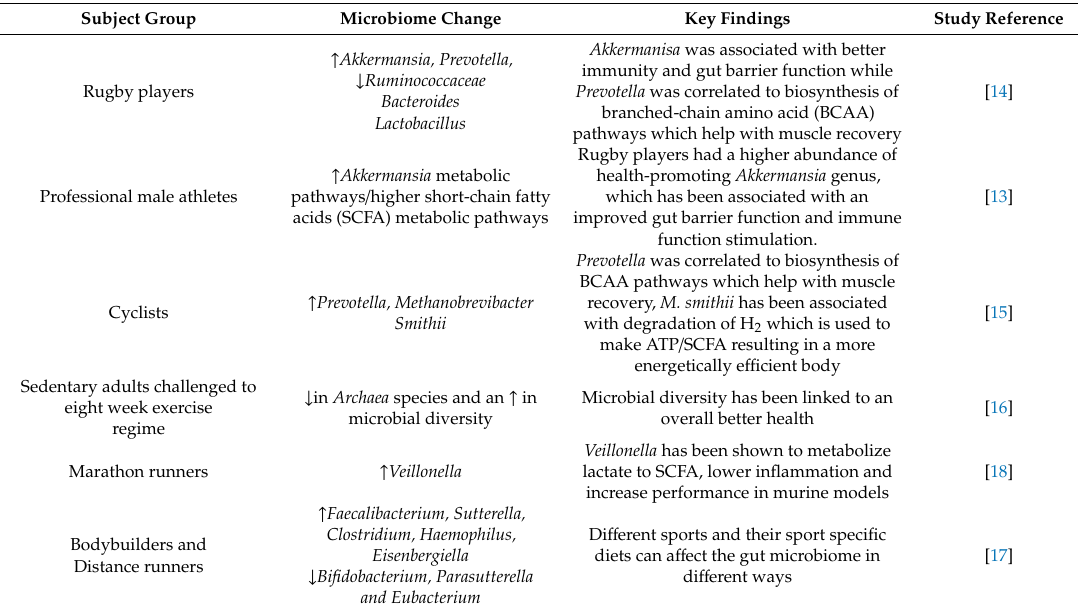
Table 1. Studies of exercise and the microbiome.